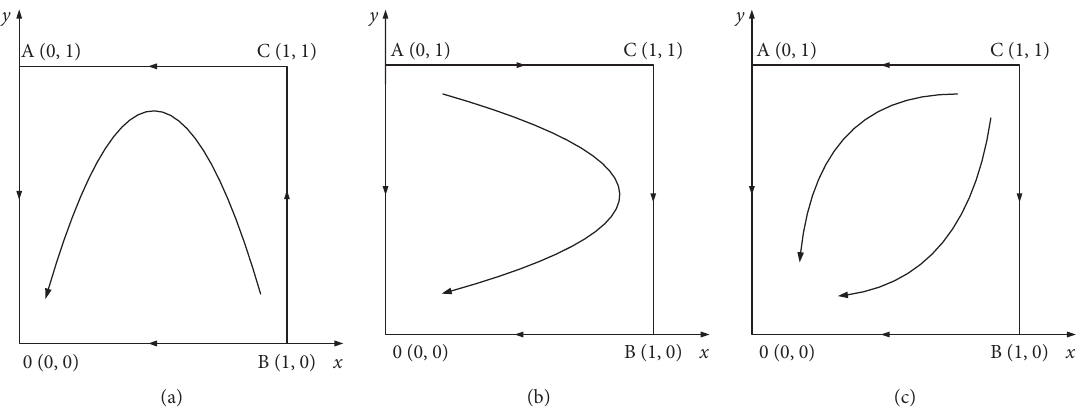
Figure 1: Evolutionary game phase diagrams (when origin O (0, 0) is the ESS). (a) Situation I. (b) Situation II. (c) Situation